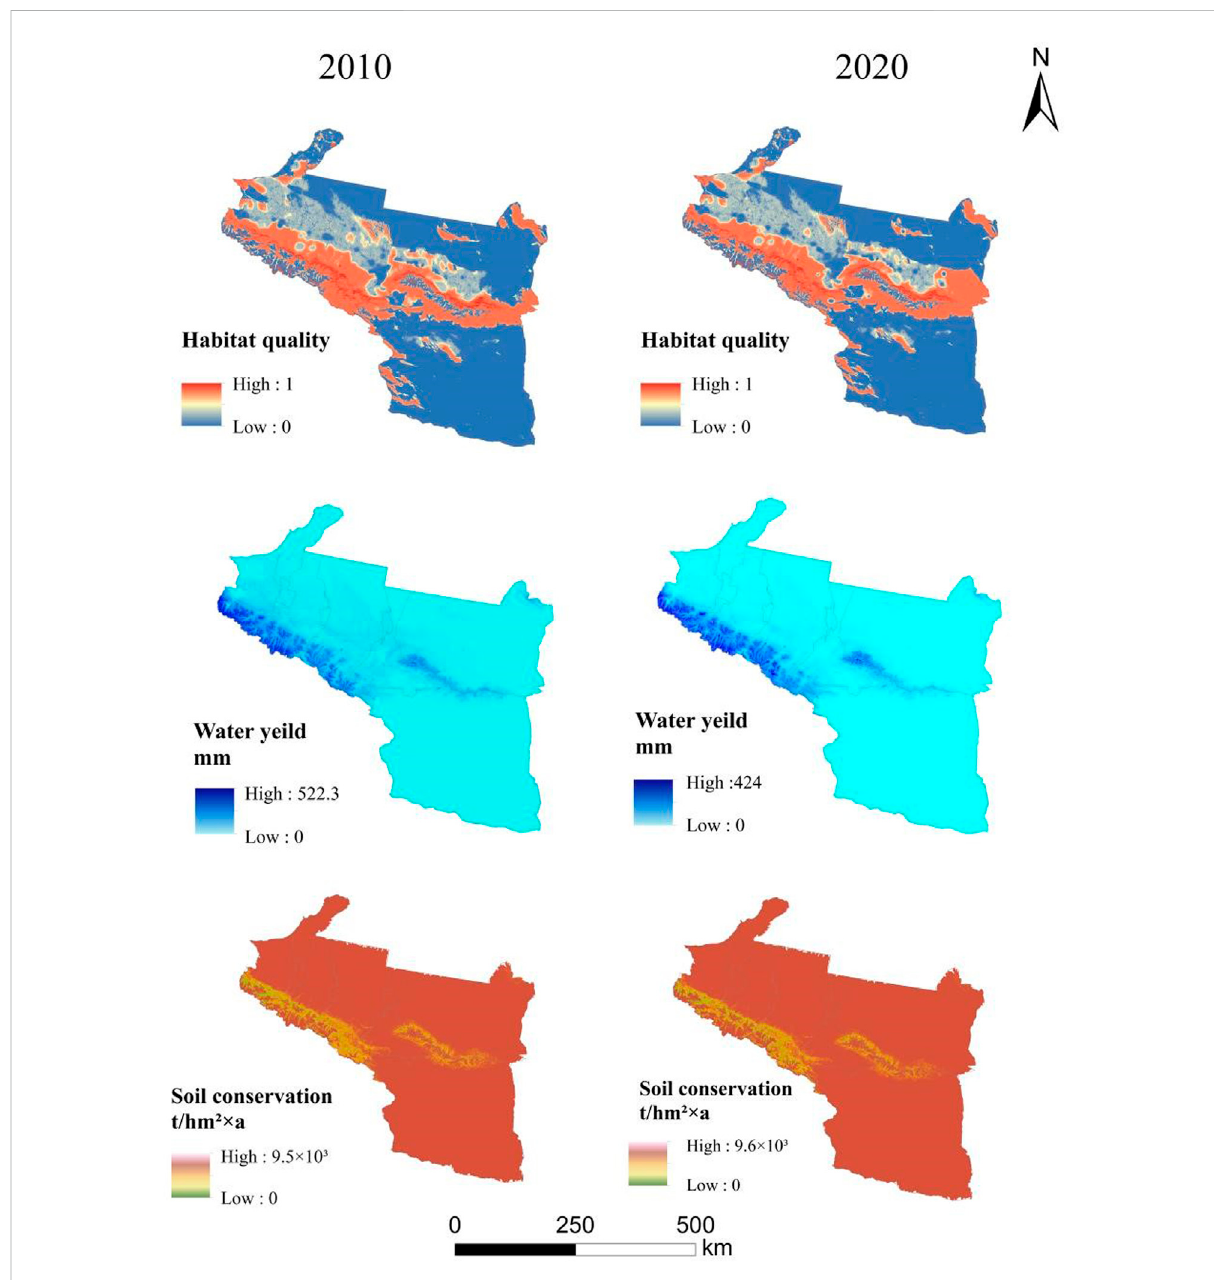
FIGURE 4 Ecosystem service spatial distribution from 2010 to